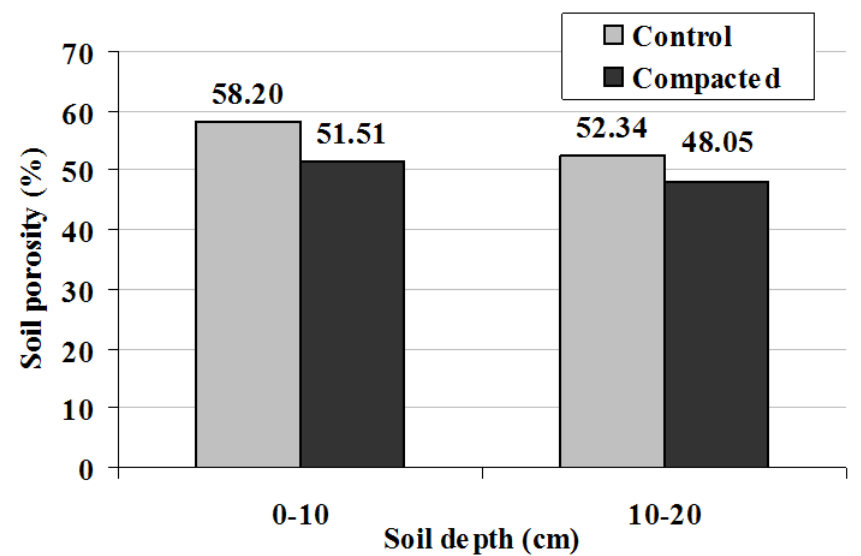
Fig. 4. Comparison of soil porosity in both control and compacted tail in the soil depth